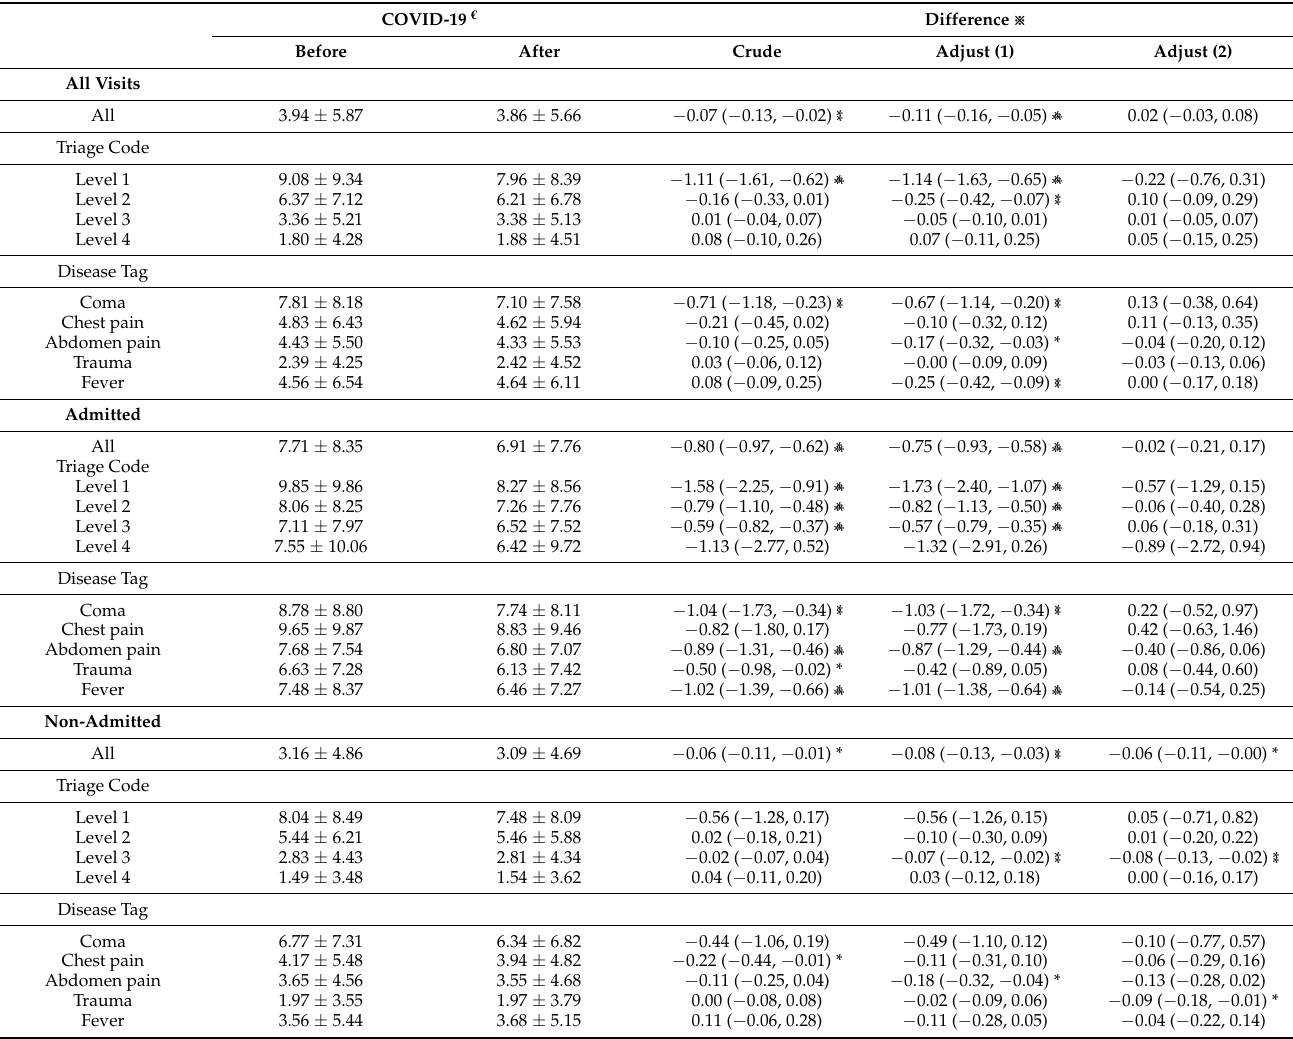
Table 5. Comparisons of length of stay before and after the start of the COVID-19 pandemic in the emergency department. COVID-19 € Difference ※ Before After Crude Adjust (1) Adjust (2) All Visits